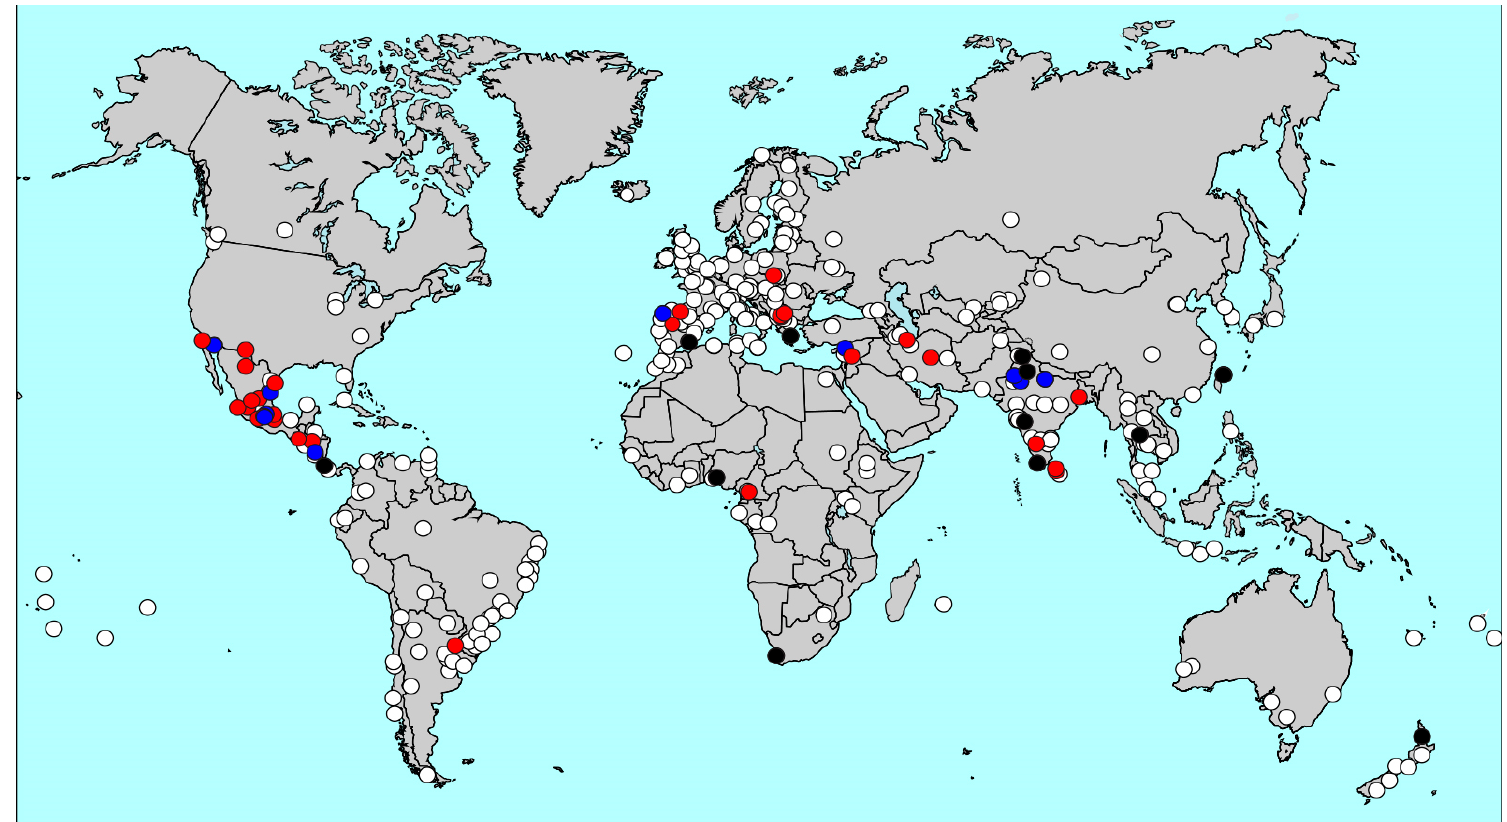
Figure 2. Overlap of GAN Phase I and ISAAC Centres. Centres that completed GAN Phase I checks before 31 May 2020 (red); GAN Phase I centres included in ISAAC Phase III but not ISAAC Phase I (blue); GAN Phase I centres included in ISAAC Phase I and ISAAC Phase III (black*); ISAAC Phase III only centres (white). * Athens, Greece contributed data to GAN and ISAAC Phase I, but not ISAAC Phase III.